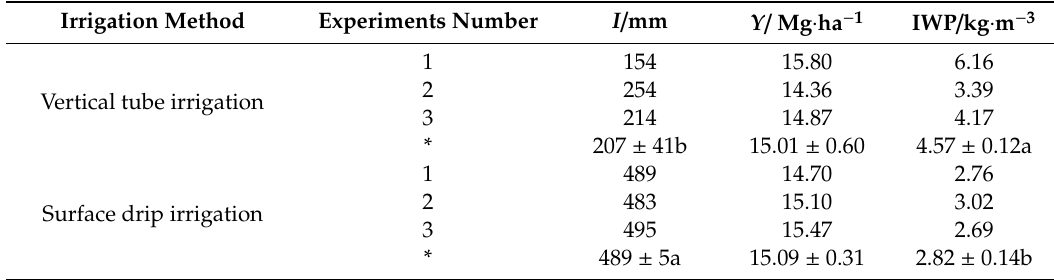
Table 4. Jujube trees yield, irrigation water amount, and irrigation water productivity (IWP) under di ff erent treatments in the experimental years.